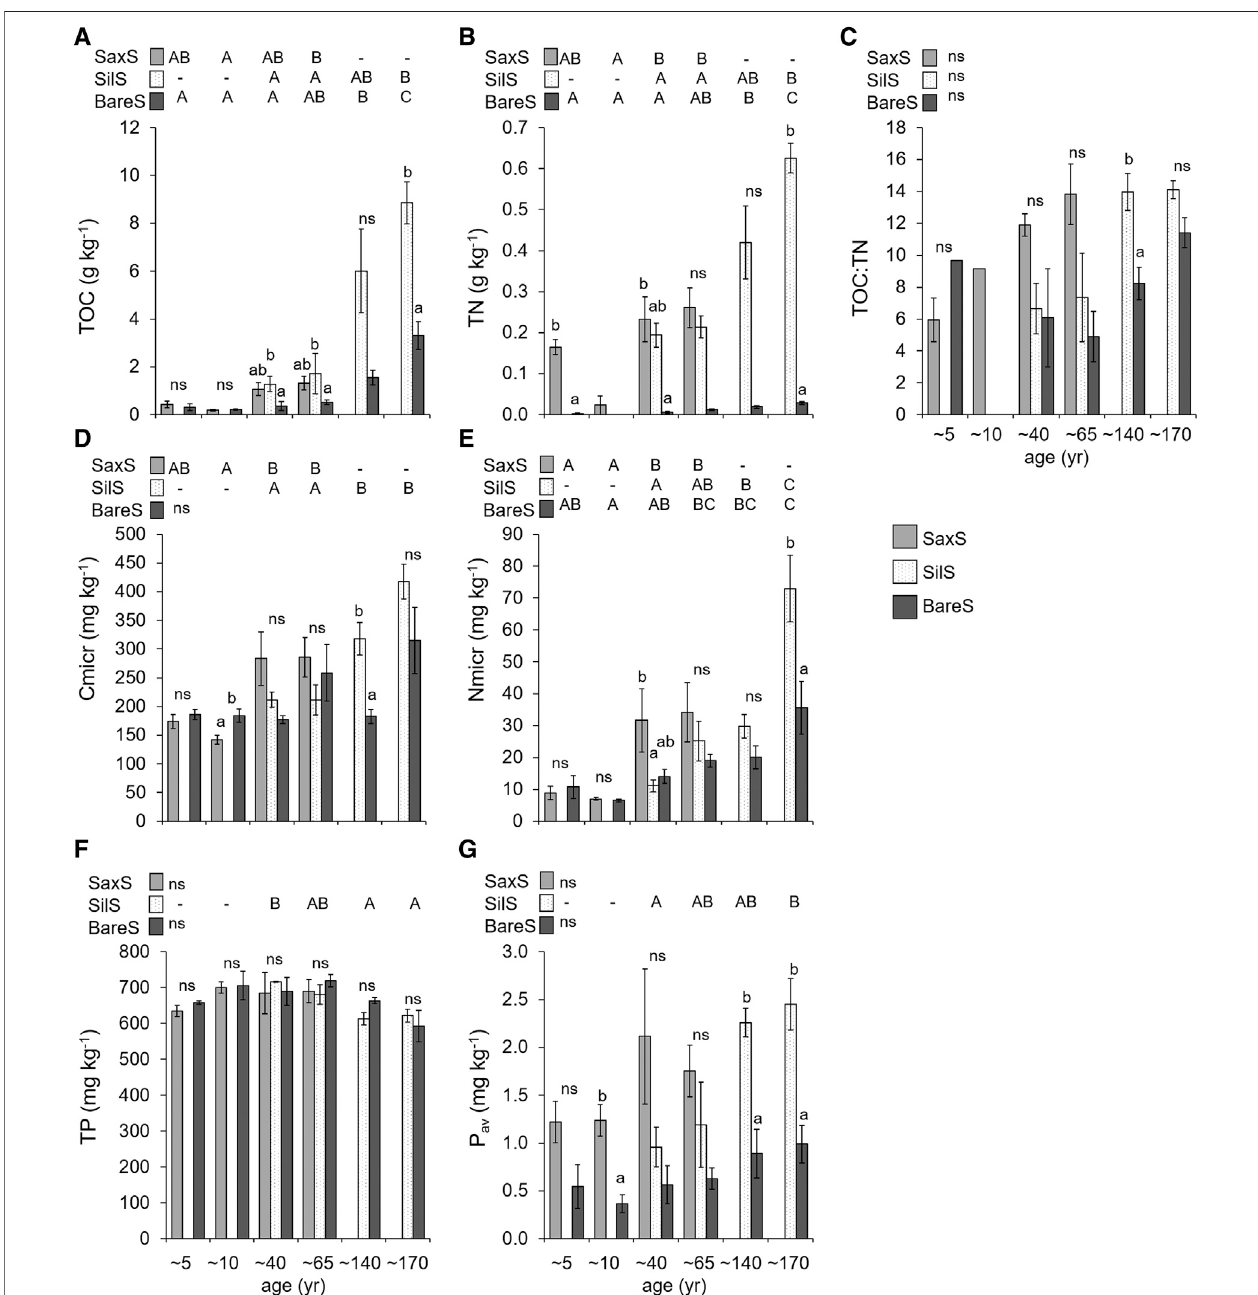
FIGURE 5 | Chemical properties of target soils along the six stages of the chronosequence. SaxS, soil under individuals of Saxifraga oppositifolia L. subsp. glandulifera Vacc.;SilS,soilunder Sileneacaulis (L.)Jacqsubsp. bryoides (Jord.)Nyman;BareS,baresoil;TOC,totalorganiccarbon (A) ;TN,totalnitrogen (B) ;TOC:TN, total carbon to nitrogen ratio (C) ; C micr , microbial carbon (D) ; N micr , microbial nitrogen (E) ; TP, total phosphorus (F) ; P av , bicarbonate extractable (available) phosphorus (G) . Different letters indicate signi fi cant differences ( p < 0.05) among stages within each target soil (uppercase letters) and among target soils within each stage (lowercase letters) according to Tukey ’ s HSD test. ns, p ≥